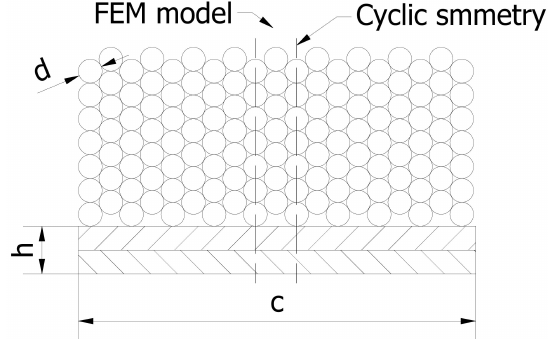
Figure 3: Cross-section of the segment of seal with bimetal element